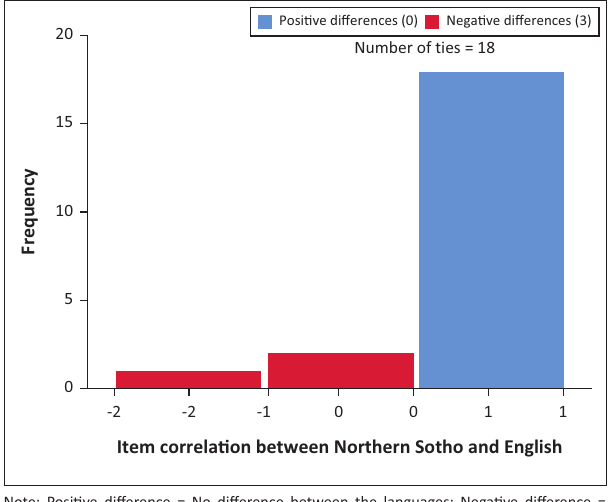
TABLE 2 : Response frequency for Northern Sotho and adapted English Modified Checklist for Autism in Toddlers, Revised with Follow-Up. Question Yes (Northern Sotho)